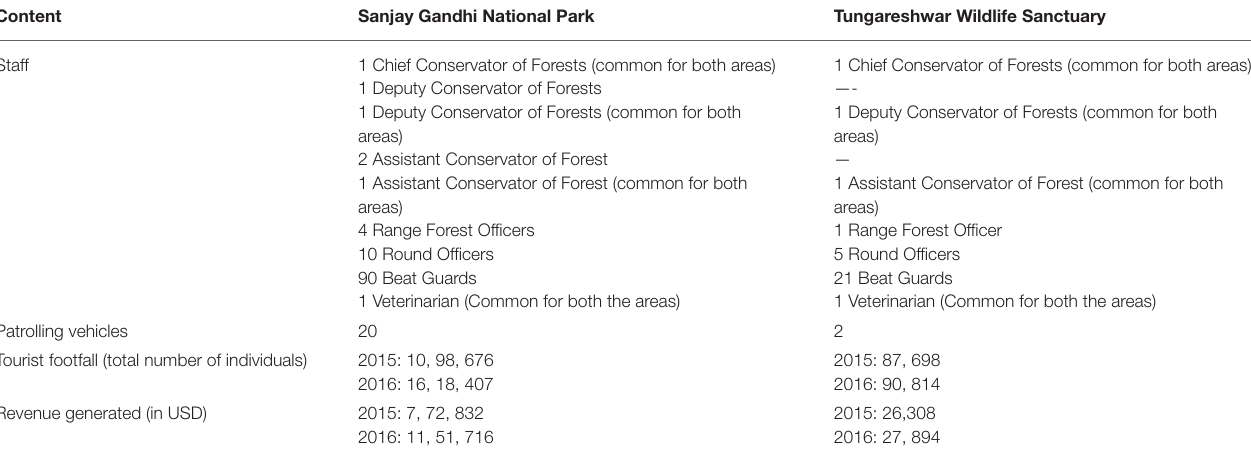
TABLE 6 | Comparison of management structure and revenue between Sanjay Gandhi National Park and Tungareshwar Wildlife Sanctuary.